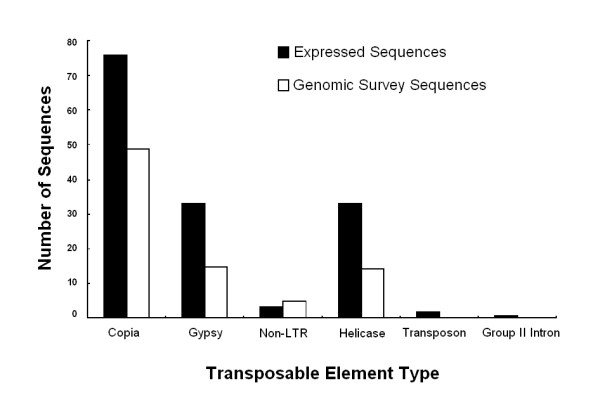
Comparison of expressed and genomic copies of Microbotryum violaceum transposable elements. Class I elements are represented by the Copia, Gypsy, and Non-LTR (long-terminal repeat) categories; Class II elements are represented by the Helicase and DNA Transposon categories. The Group II Intron category corresponds to a mitochondrial mobile element. The data on genomic survey sequences are from ref [12].